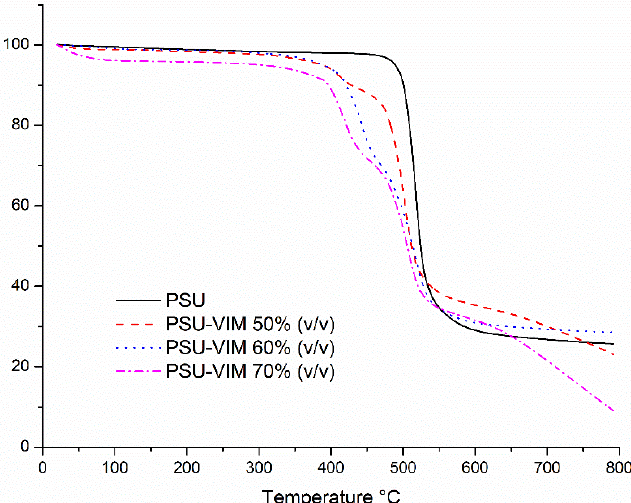
Figure 6. Thermal behavior obtained from TGA analysis for the grafted PSU membranes with an irradiation dose of 300 kGy and VIM concentrations between 50–70% (v/v).